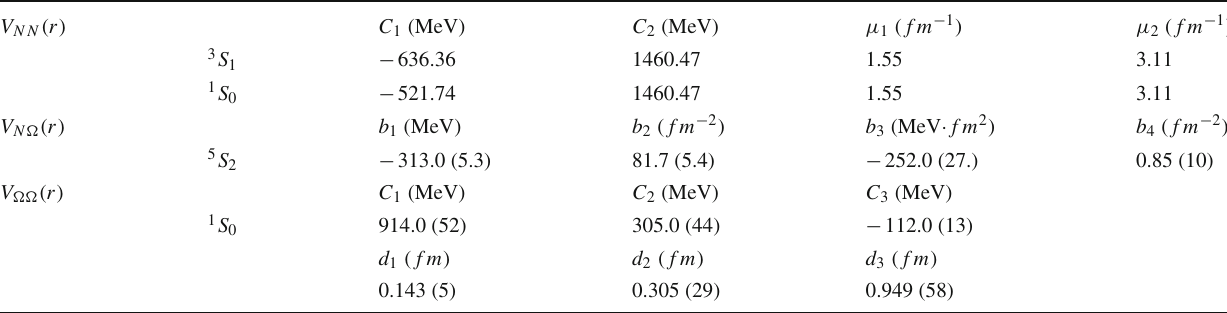
Table 2 Parameters of potentials V NN ( r ) [43], V N (cid:3) ( r ) , V (cid:3)(cid:3) ( r ) [17,18] V NN ( r